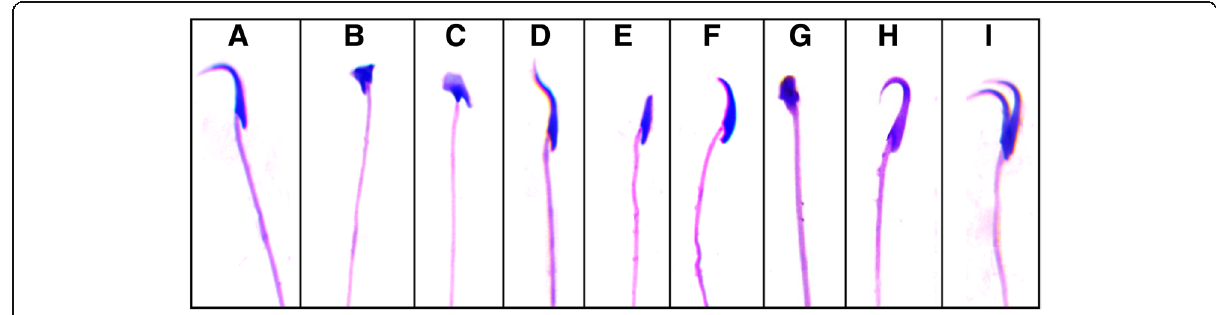
Fig. 25 Different types of head shape anomalies after CCl4 and/or NAC treatment. a Normal. b Triangular. c Collapsed. d Deformed orientation. e Banana shape. f Without hook. g Amorphous. h Acute curvature. i Double